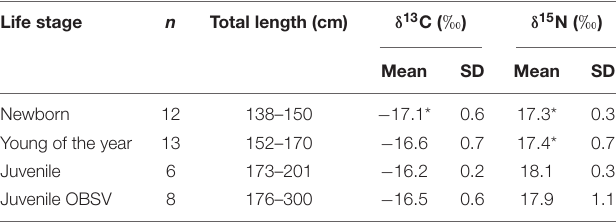
*Indicates significant differences between life stages tested with one-way ANOVA and Tukey post hoc test. Differences between juveniles inside BSV and OBSV were tested with the Kruskal-Wallis test. The significance level is